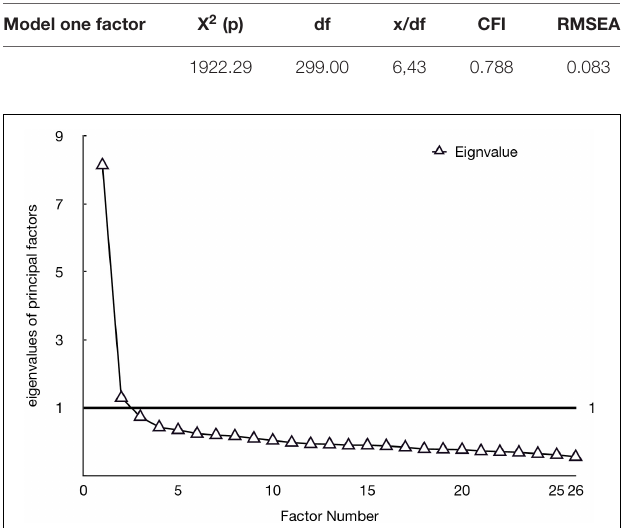
TABLE 2 | Fit indices for de confirmatory analyses of the Perception of objectification on the workplace (Auzoult and Personnaz, 2016a) ( N = 780). Model one factor